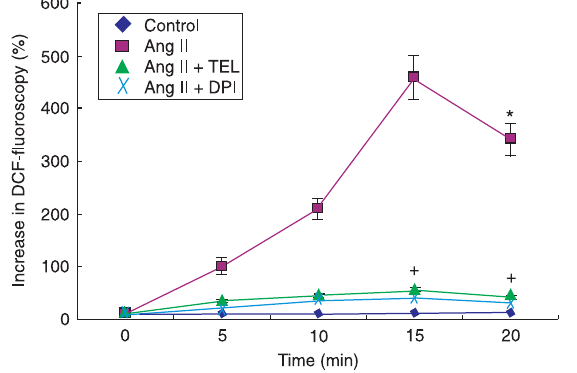
Figure 3. A, Angiotensin II (Ang II) stimulates the protein synthesis of p47 phox in rat GECs at a fixed dose of 10 μ M. The p47 phox protein level increased in a time-dependent way, reaching the peak at 8 h. B, DPI and TEL reduced Ang II-induced p47 phox synthesis. GECs = glomerular endothelial cells; DPI = diphenyleneiodonium; TEL = telmisartan. *P < 0.01 vs control group; + P < 0.05 vs Ang II group (N = 3; Bonferroni test).